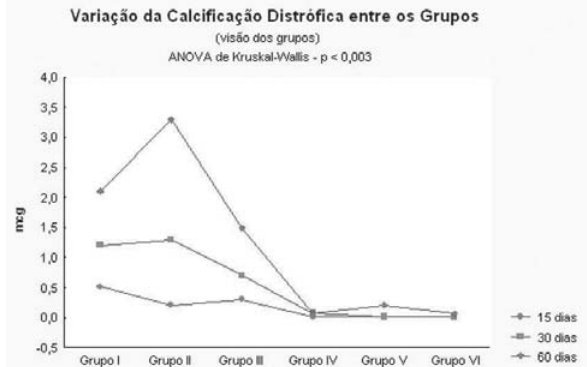
Fig.1 - Calcificação em 60 dias após implante - fotomicrografia mostrando os graus de calcificação do pericárdio bovino de acordo com os tratamentos empregados nos grupos I, II, III, IV, V e VI,